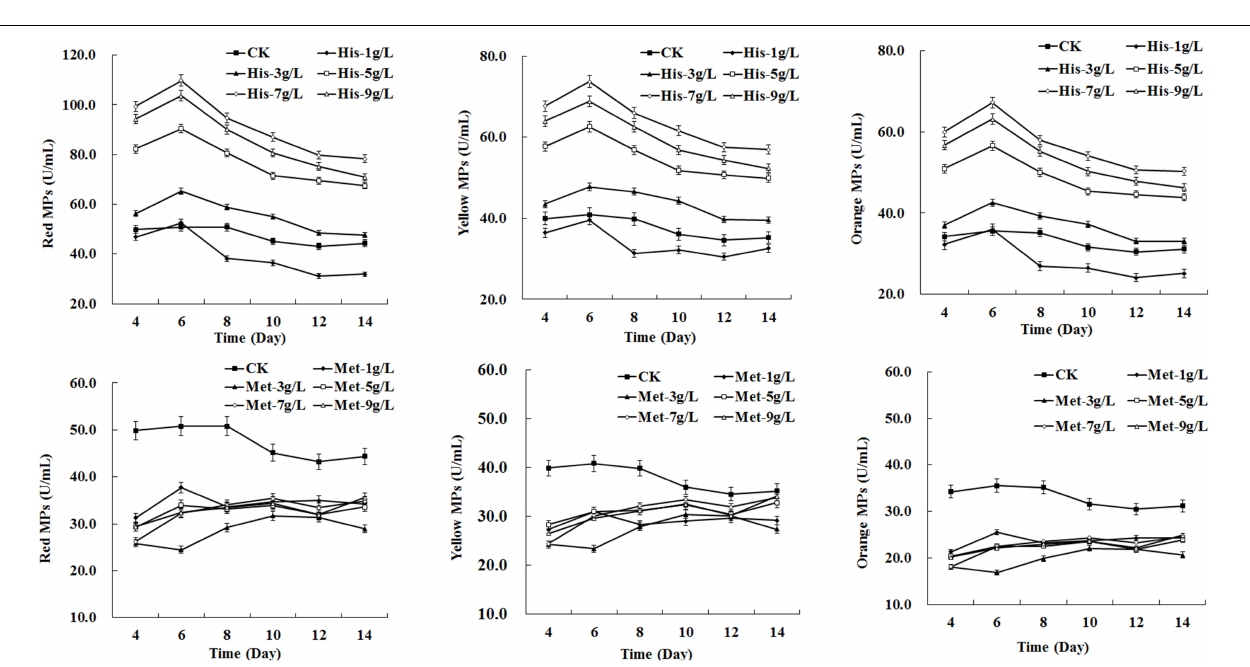
FIGURE 2 | Effects of amino acids at different concentrations on Monascus pigments (MPs) production in Monascus purpureus RP2 fermentation. CK, M. purpureus RP2 fermentation without the addition of amino acid; His, M. purpureus RP2 fermentation with the addition of HIS; Met, M. purpureus RP2 fermentation with the addition of MET.